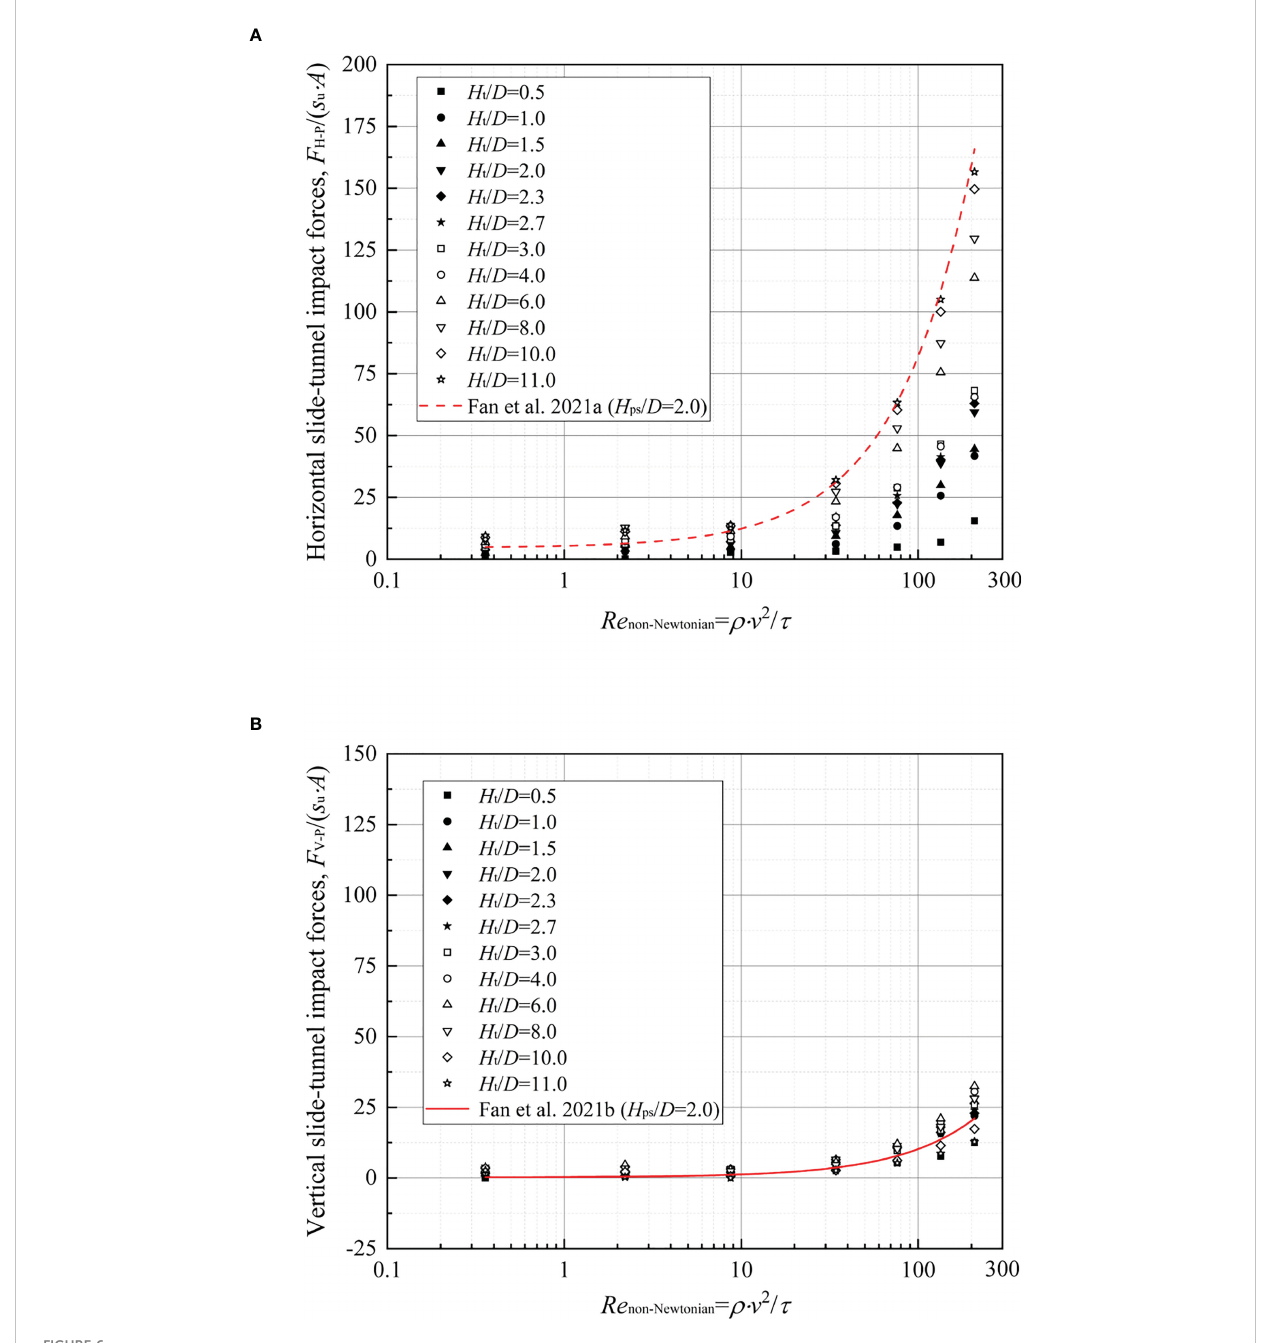
FIGURE 6 Peak impact forces during submarine slide-tunnel interaction at different Reynolds numbers (an example of the octagon section): horizontal impact forces (A) and vertical impact forces (B)